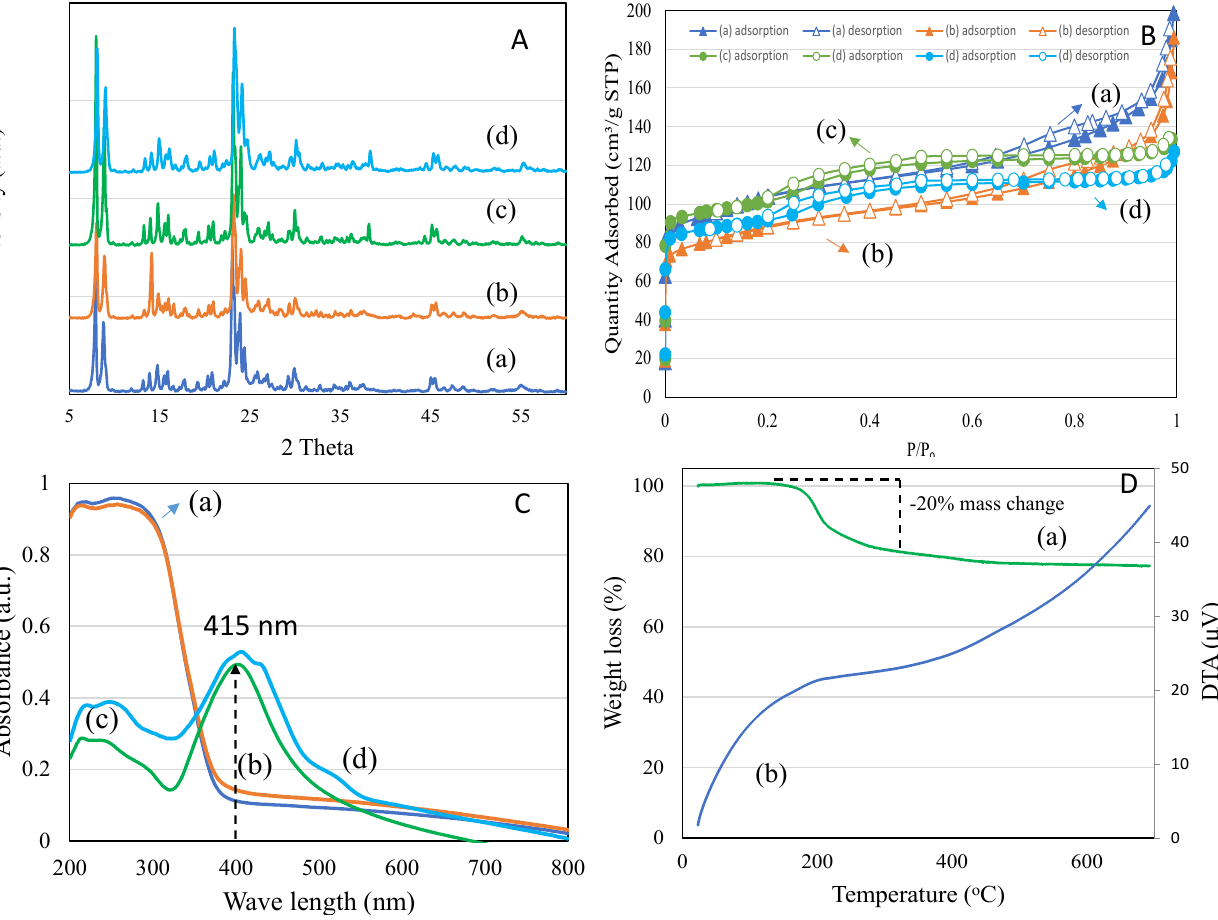
Figure 6. ( A ) X-ray diffraction ( a ) TiZSM-5, ( b ) 4 wtAg/TiZSM-5, ( c ) Ag-silicalite-1 (Ag/Si ratio 25) and ( d ) Ag-silicalite-1 (Ag/Si ratio 100), ( B ) N2 adsorption isotherm of ( a ) TiZSM-5, ( b ) 4 wtAg/TiZSM-5, ( c ) Ag-silicalite-1 (Ag/Si ratio 25) and ( d ) Ag-silicalite-1 (Ag/Si ratio 100), ( C ) diffuse reflectance spectra of ( a ) TiZSM-5, ( b ) 4 wtAg/TiZSM-5, ( c ) Ag-silicalite-1 (Ag/Si ratio 25) and ( d ) Ag-silicalite-1 (Ag/Si ratio 100) and ( D ) TGA-DTA measurement of as-synthesized Ag-silicalite-1. Table 3. Textural characteristics of ZSM-5 modified samples.